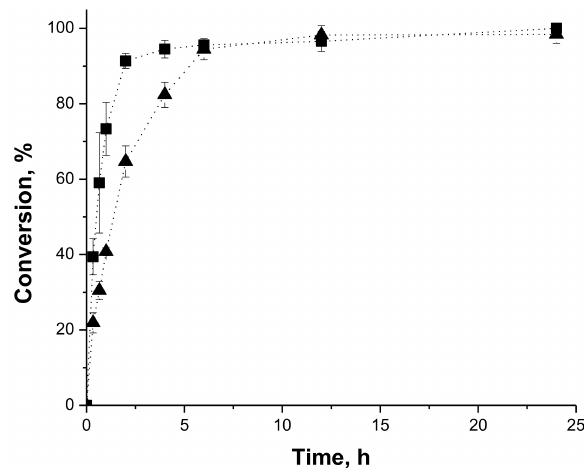
Figure 2. Time-conversion profiles of synthesis of butyl butyrate at 37 ◦ C catalyzed by PFL-octyl-silica in heptane, using 0.1 M for acids and alcohols, 200 U/g of acid (esterification activity) and 20 g/L molecular sieves. The conversions were assessed by consumption of 1-butanol by gas chromatography (squares) and butyric acid by titration (triangles).